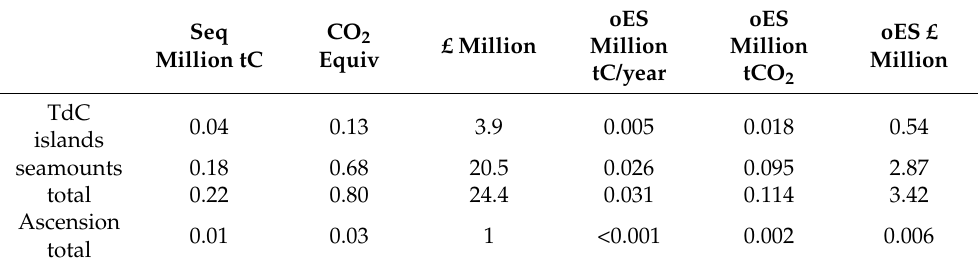
Table 7. Sequestered zoobenthic carbon, CO 2 equivalent and its value on seabed area <1000 m depth around the Tristan da Cunha archipelago compared with that around Ascension Island. The columns are from left to right; localities, total sequestered zoobenthic carbon in million tonnes on the basis of surface area (Seq million t), their equivalent CO 2 amount in million tonnes (CO 2 equiv), minimum value on the shadow price of carbon in £ millions GBP (£ million), annual increment, ie ongoing ecosystem services in million tonnes carbon per year (oES tC/year), annual increment in million tonnes CO 2 equivalent (oES milliont CO 2 ), and annual increment in value, £ millions (oES). oES oES oES £ Seq CO 2 Million £ Million Million Million Million tC Equiv tCO 2 tC/year TdC 0.04 0.13 3.9 0.005 0.018 0.54 islands seamounts 0.18 0.68 total 0.22 Ascension 0.01 0.03 1 <0.001 0.002 total